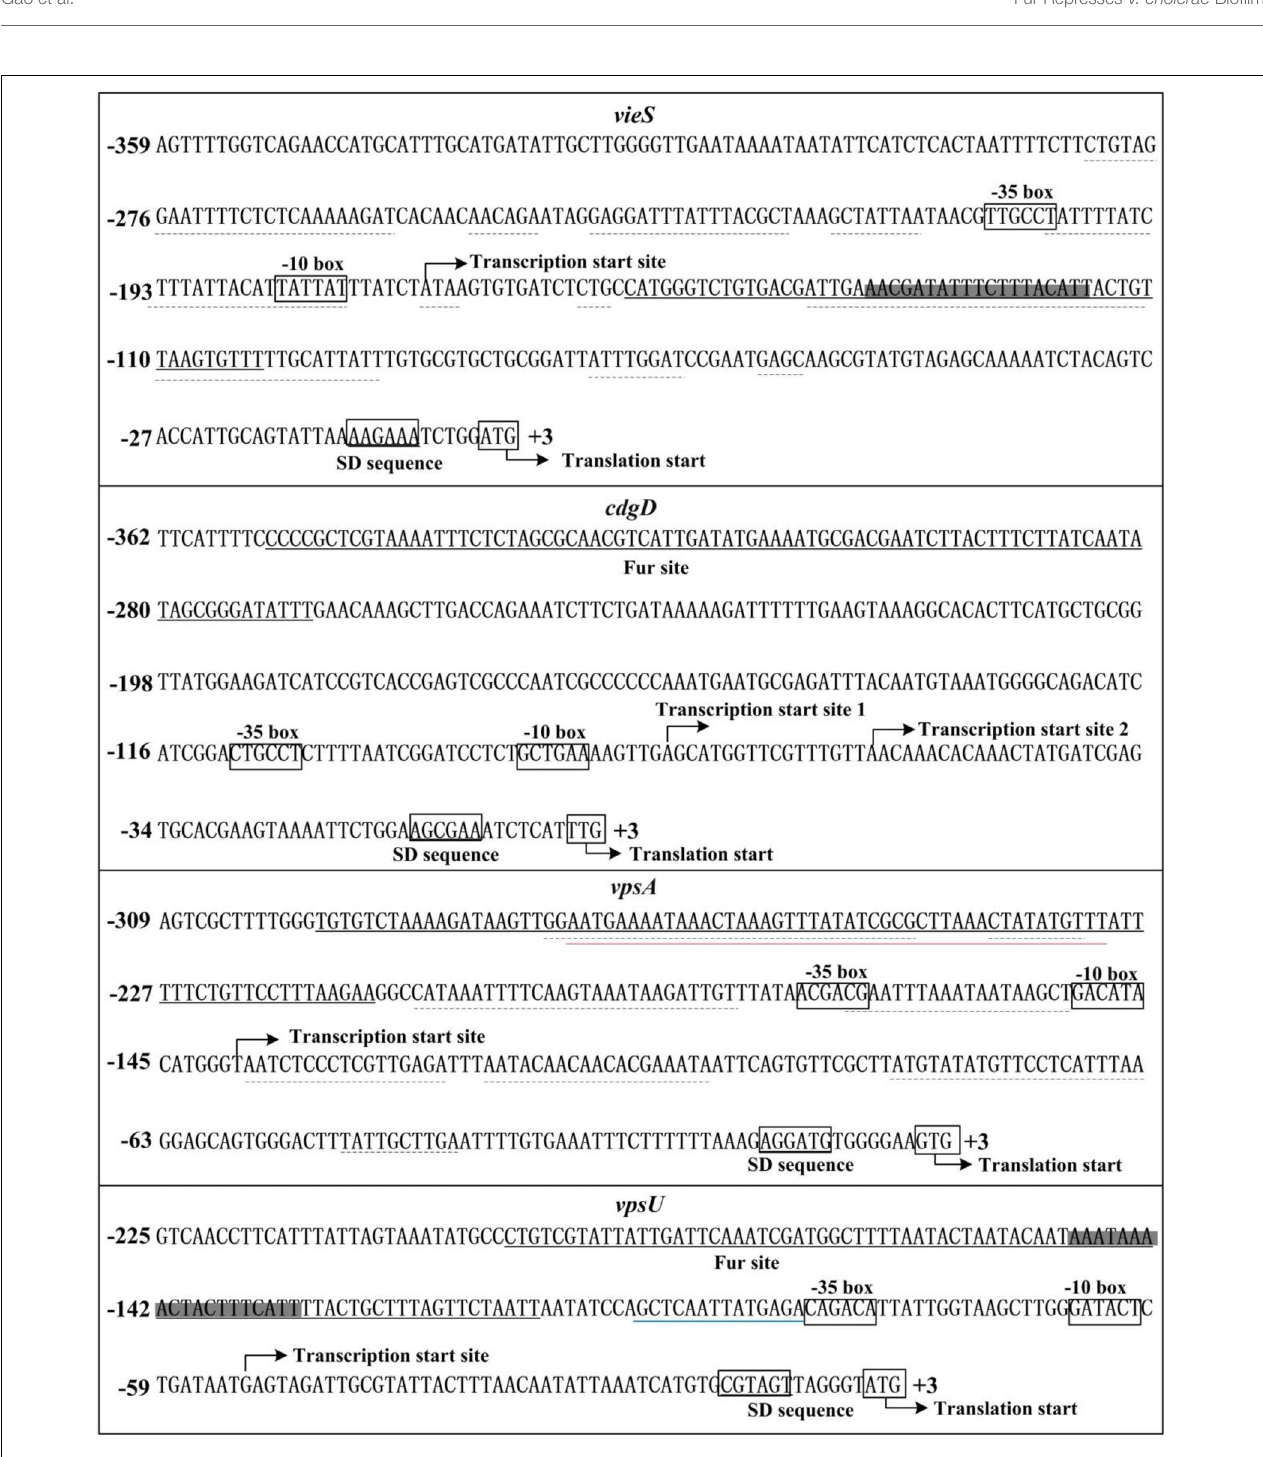
FIGURE 5 | Structural organization of targeted promoters. The DNA sequences were derived from Vibrio cholerae El Tor C7258. Transcription/translation start sites were marked with a bent arrow. Shine-Dalgarno (SD) box and –10/–35 elements were enclosed in boxes. The Fur-box like sequences was enclosed in shadowed boxes. The Fur sites were underlined with solid lines. The H-NS sites were underlined with dotted lines (Ayala et al., 2015, 2018). The VpsT site was underlined with a red line (Ayala et al., 2015). The blue line indicated the VpsR-box-like sequence (Zamorano-Sanchez et al., 2015).